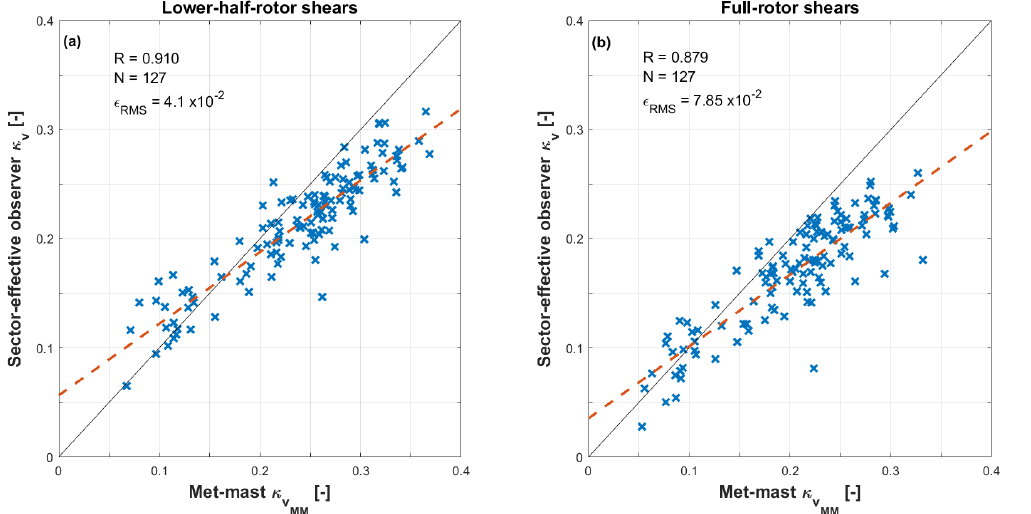
Figure 4. Correlation between 10min averages of the vertical linear shears measured with the met mast and the sector-effective observer. Lower-half-rotor shears (a) ; full-rotor shears (b) . Dashed red line: linear best fit; dashed black line: ideal match; R : Pearson’s correlation coefficient; N : number of data points; (cid:15) RMS : root mean square